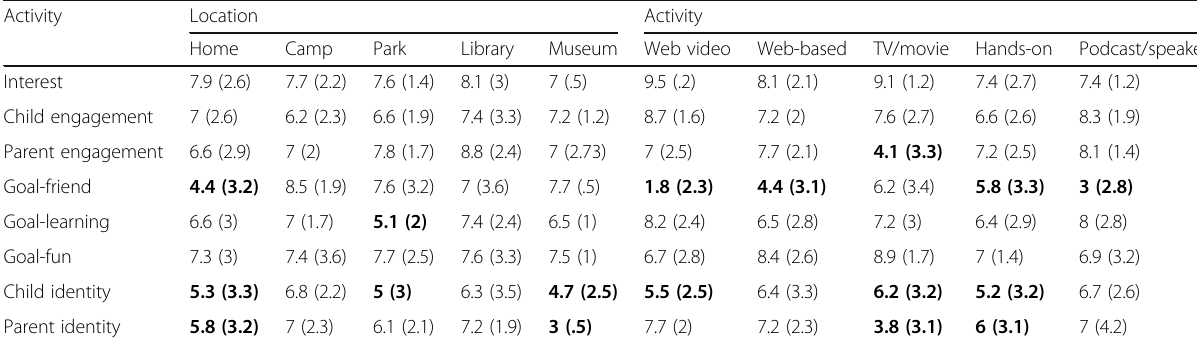
Table 3 Self-reported event ratings by location and activity Activity Location